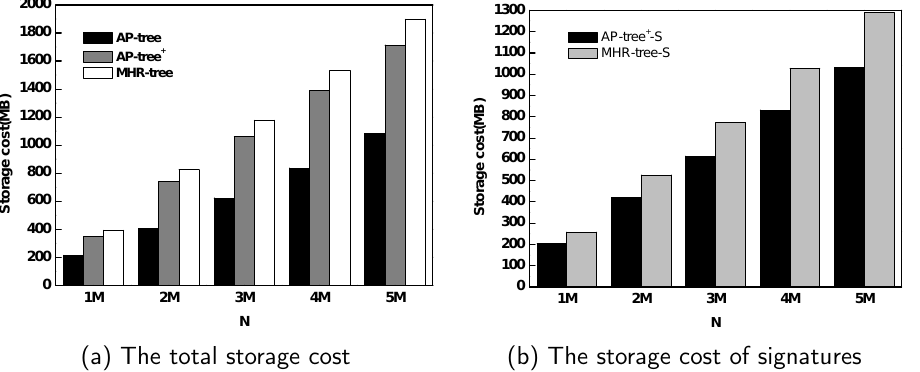
Figure 8. The space cost of AP-tree + based on AIS